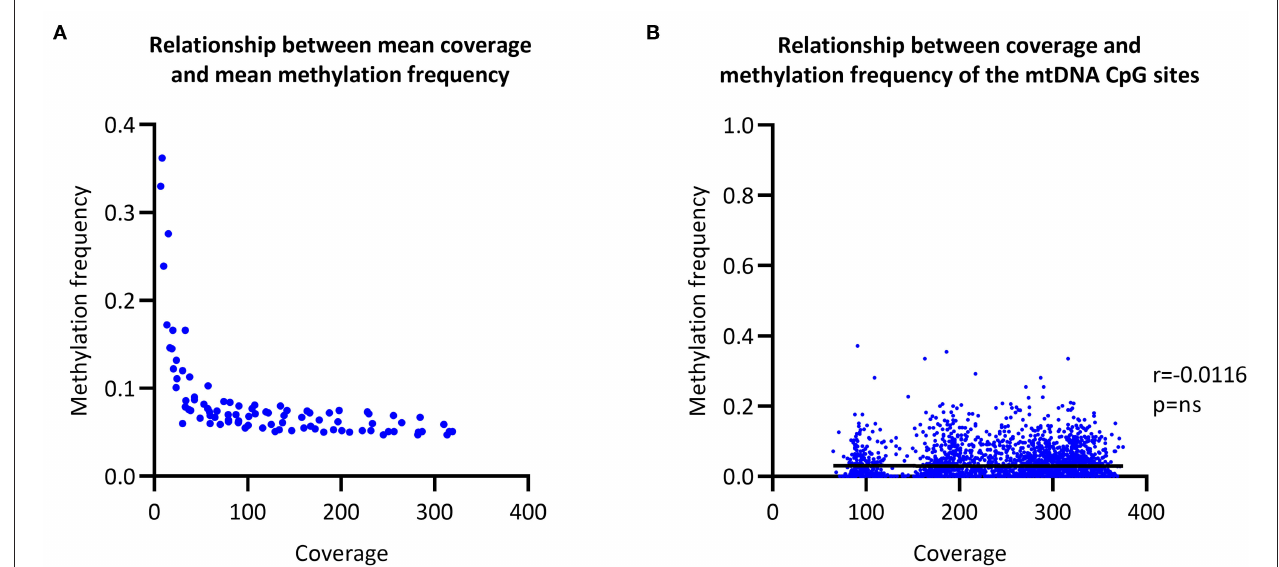
FIGURE 2 | Relationship between coverage and methylation frequency. (A) Overall relationship between the mean coverage and mean methylation frequency of different subsections of the obtained sequencing data. (B) Overall relationship between the coverage of each individual CpG site and the corresponding methylation frequency. r, Spearman’s rank correlation coefficient; p, Spearman’s exploratory p-